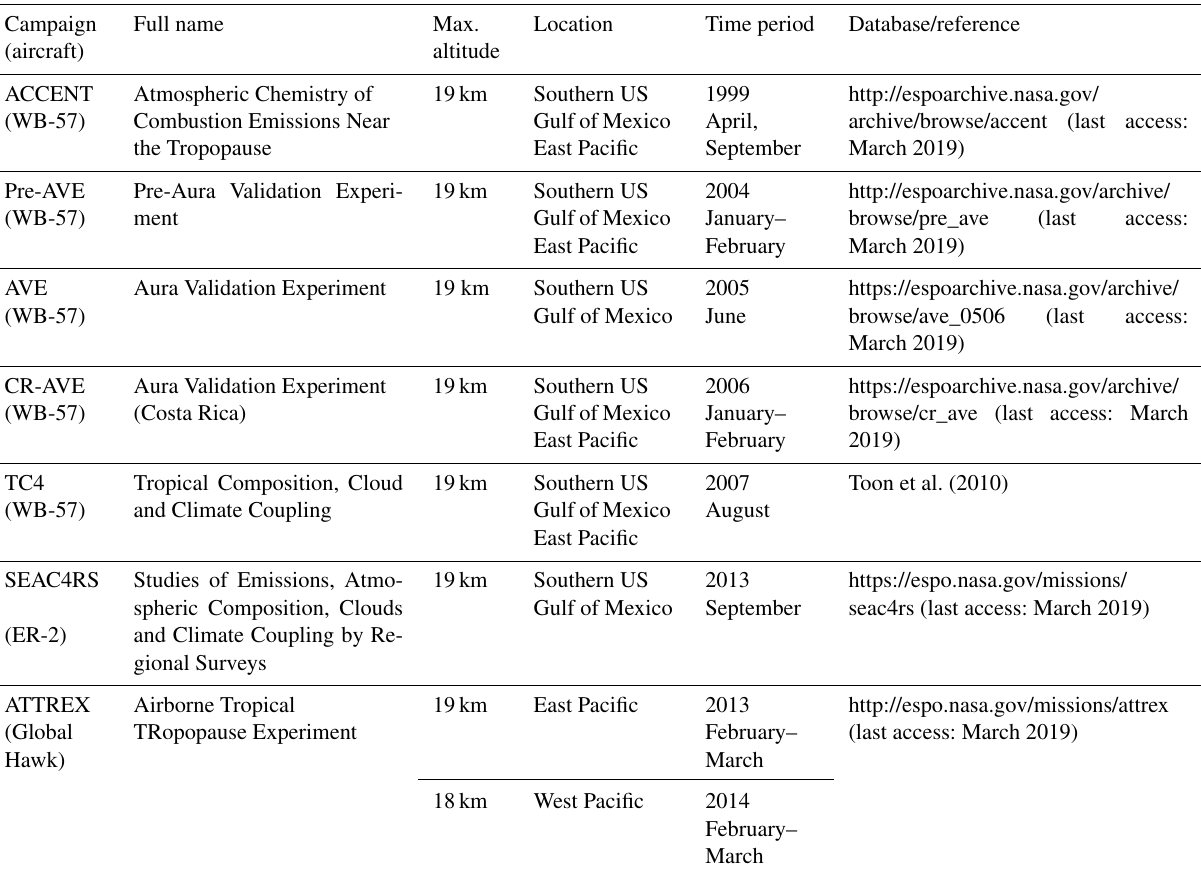
Table 1. Aircraft campaigns with CHBr 3 measurements used in the study.